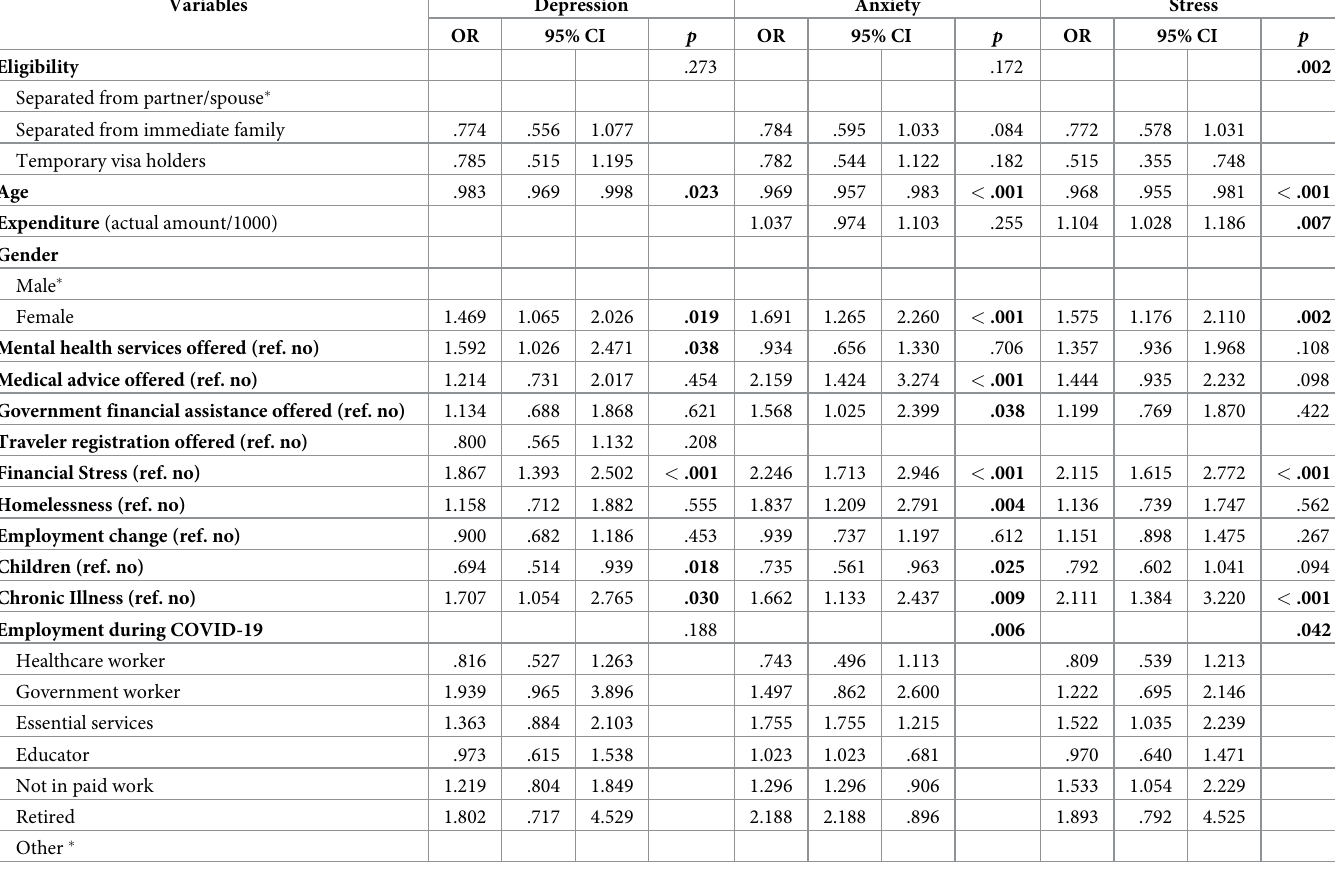
Table 6. Predictors of moderate to extremely severe depression, anxiety, and stress in temporary visa holders unable to immigrate and those separated from their partners or immediate family members during